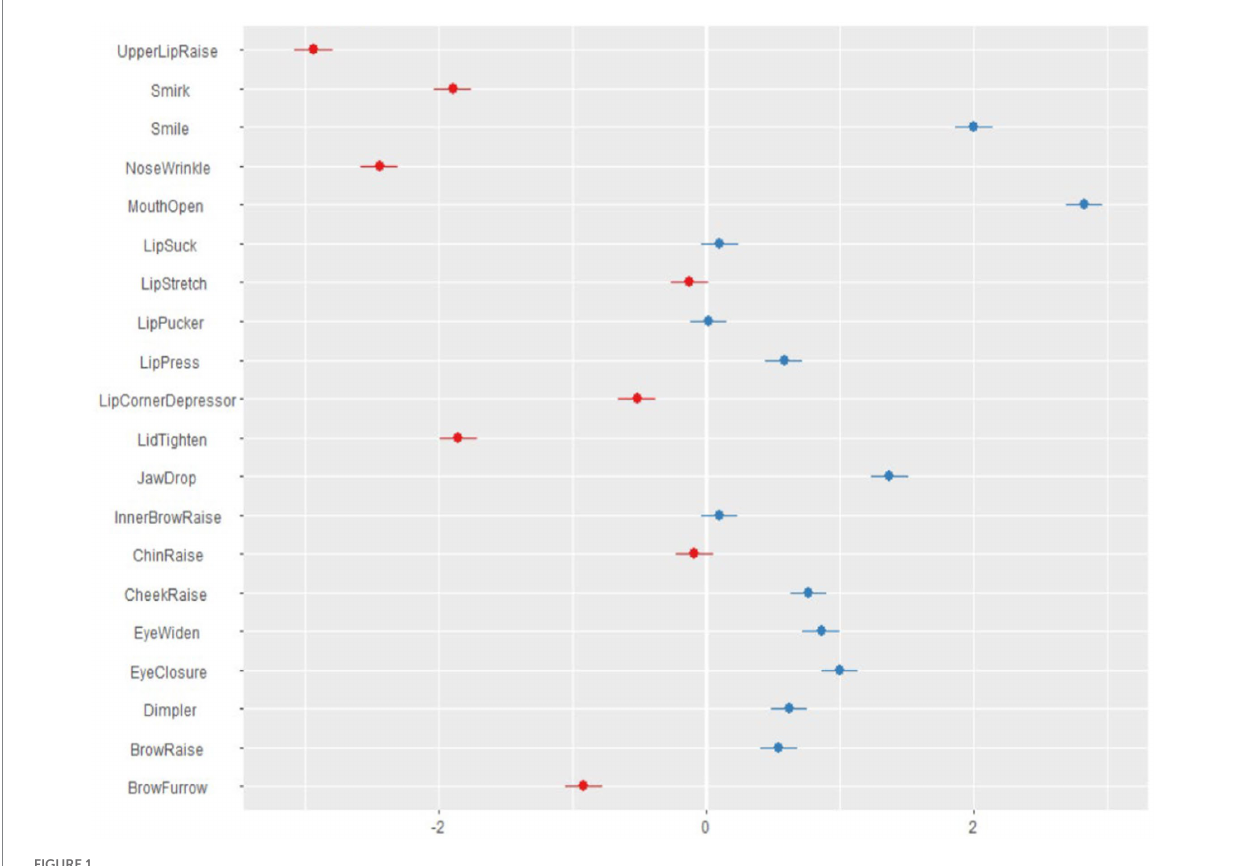
FIGURE 1 Action units of facial expressions during